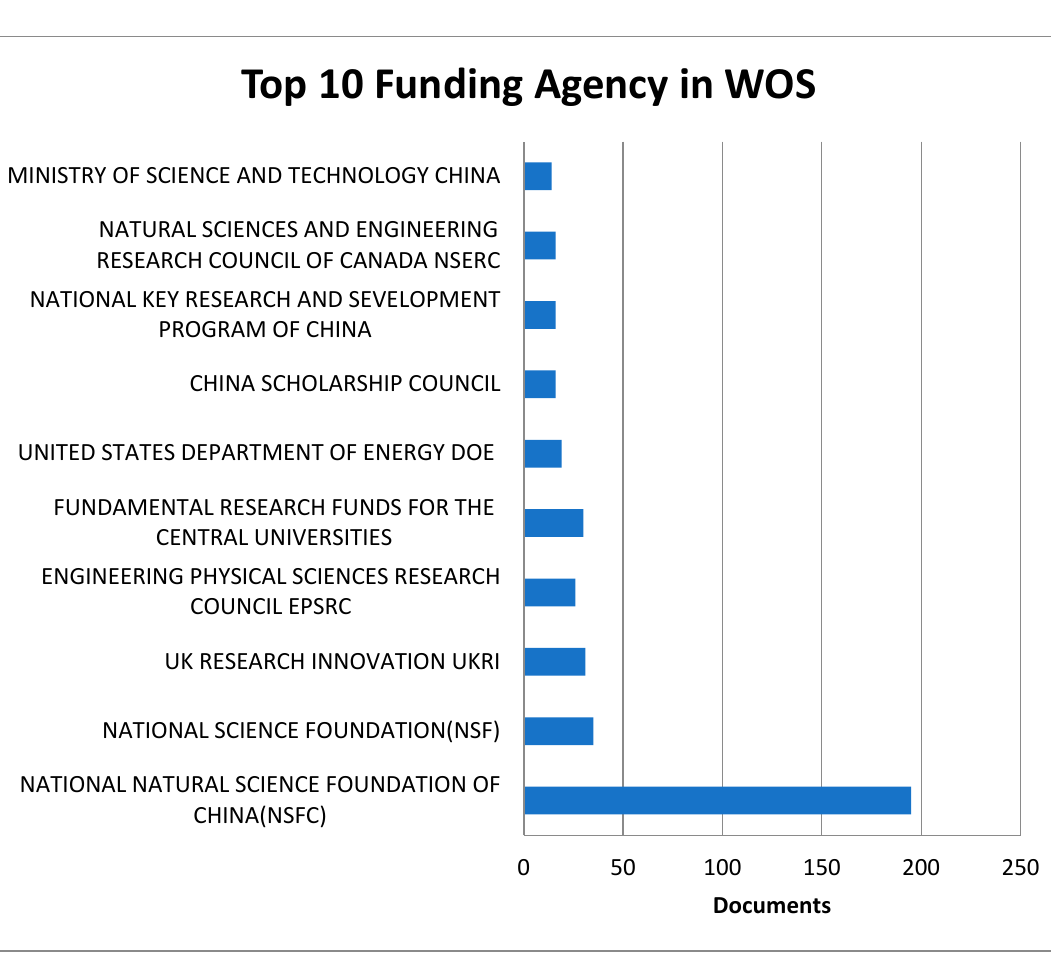
Figure 9. Top ten funding agencies in BMS EV for WOS DB.